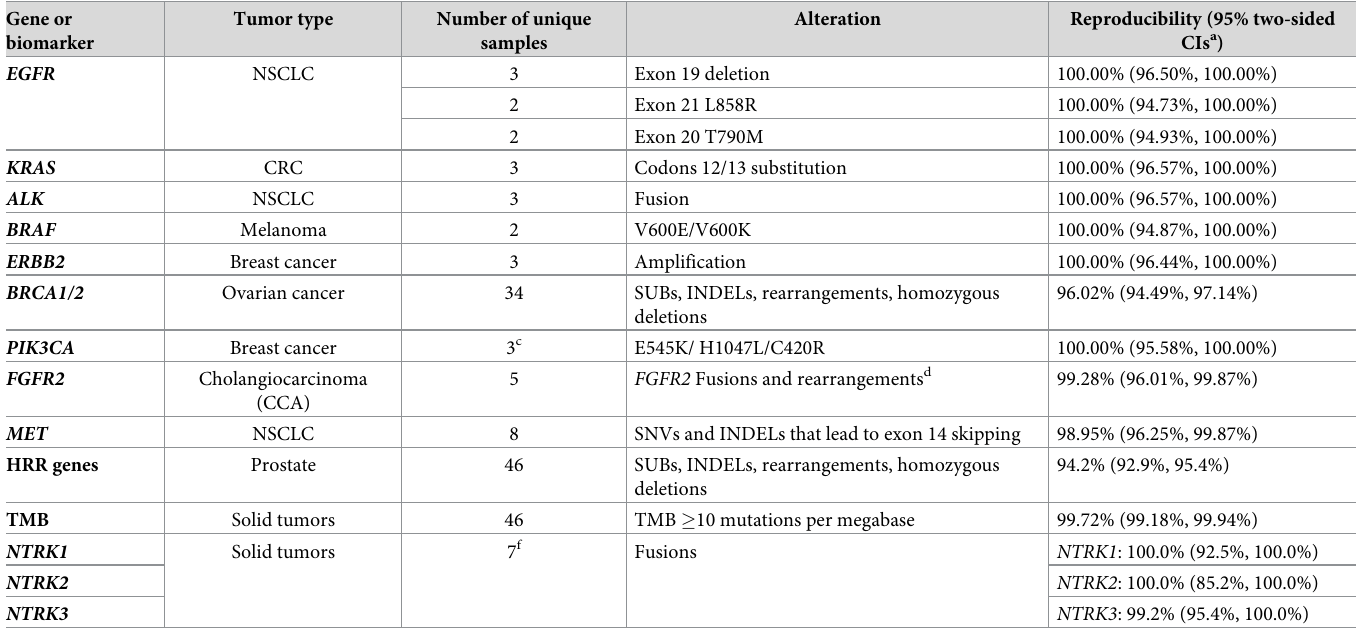
Table 10. Reproducibility of companion diagnostic